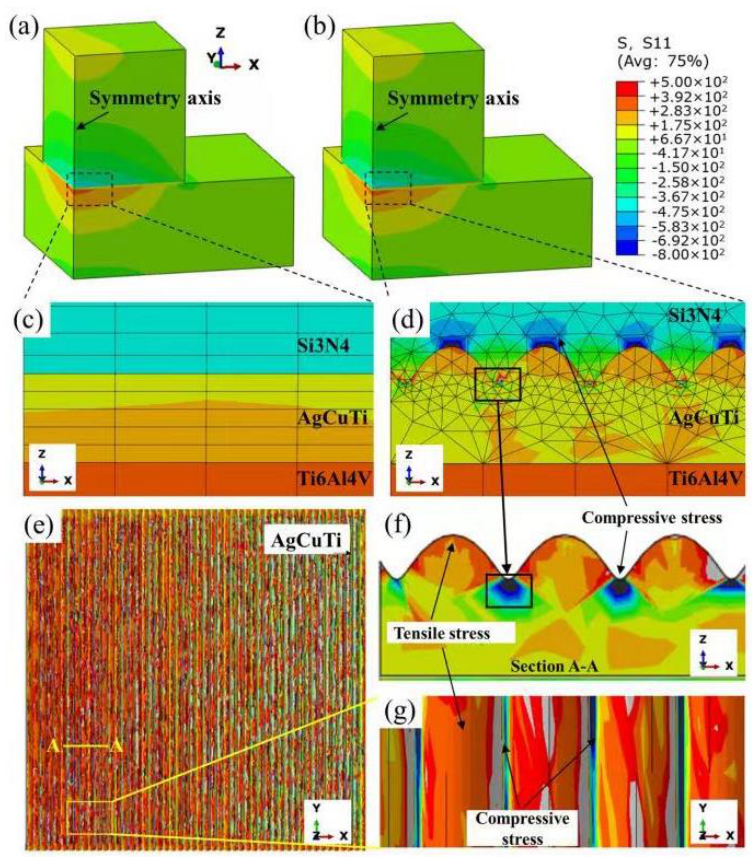
Figure 11. ( a ) Distribution cloud diagram of the residual stress τ zx in the pristine surface, ( b ) dense surface joint, ( c ) pristine surface, ( d ) local enlarged view of the dense surface joint, ( e ) AgCuTi in the dense surface joint residual stress distribution, ( f ) corresponding local cross-section, and ( g ) surface stress state.